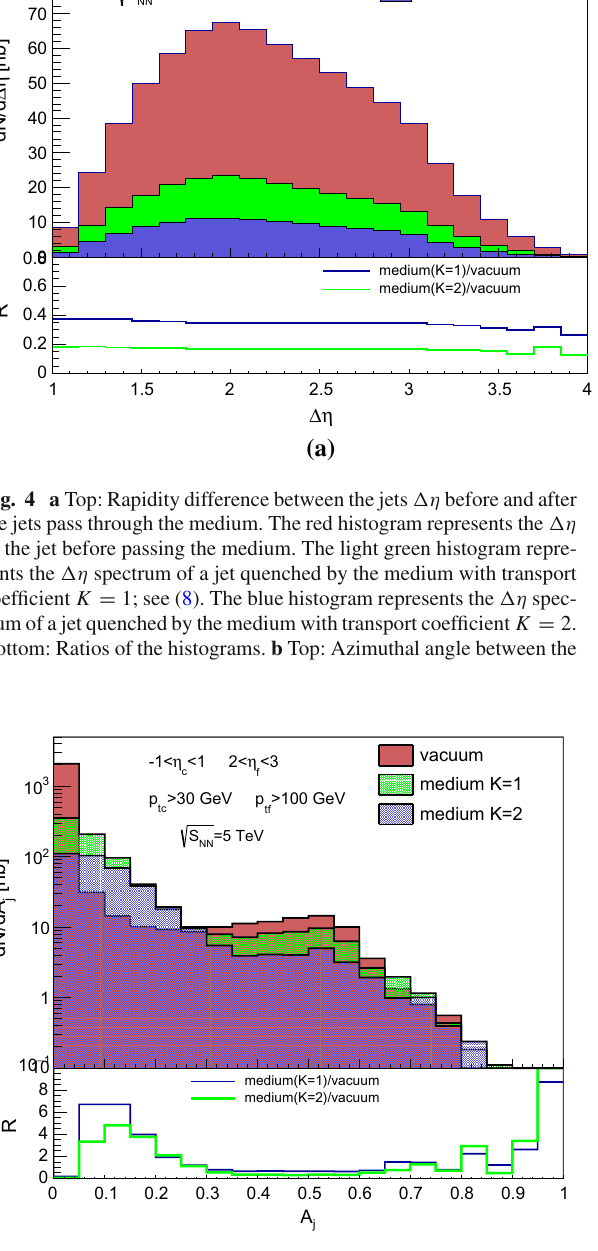
Fig. 5 Top: Relative transversal momentum difference between the jets A j before and after the jets passed through the medium. The red histogram represents the A j of the jet without passing the medium. The green transparent histogram represents the A j spectrum of a jet quenched by the medium with K = 1; see (8). The blue transparent histogram represents the A j spectrum of a jet quenched by the medium with K = 2. Bottom: Ratios of the